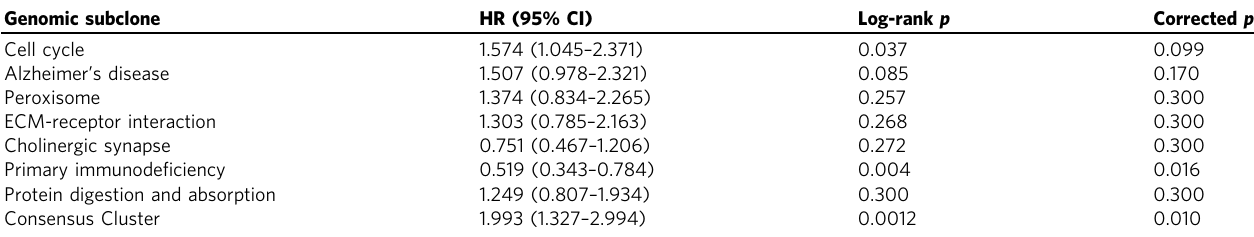
Table 2 Tumour subclones for survival analysis in the genomic development dataset.